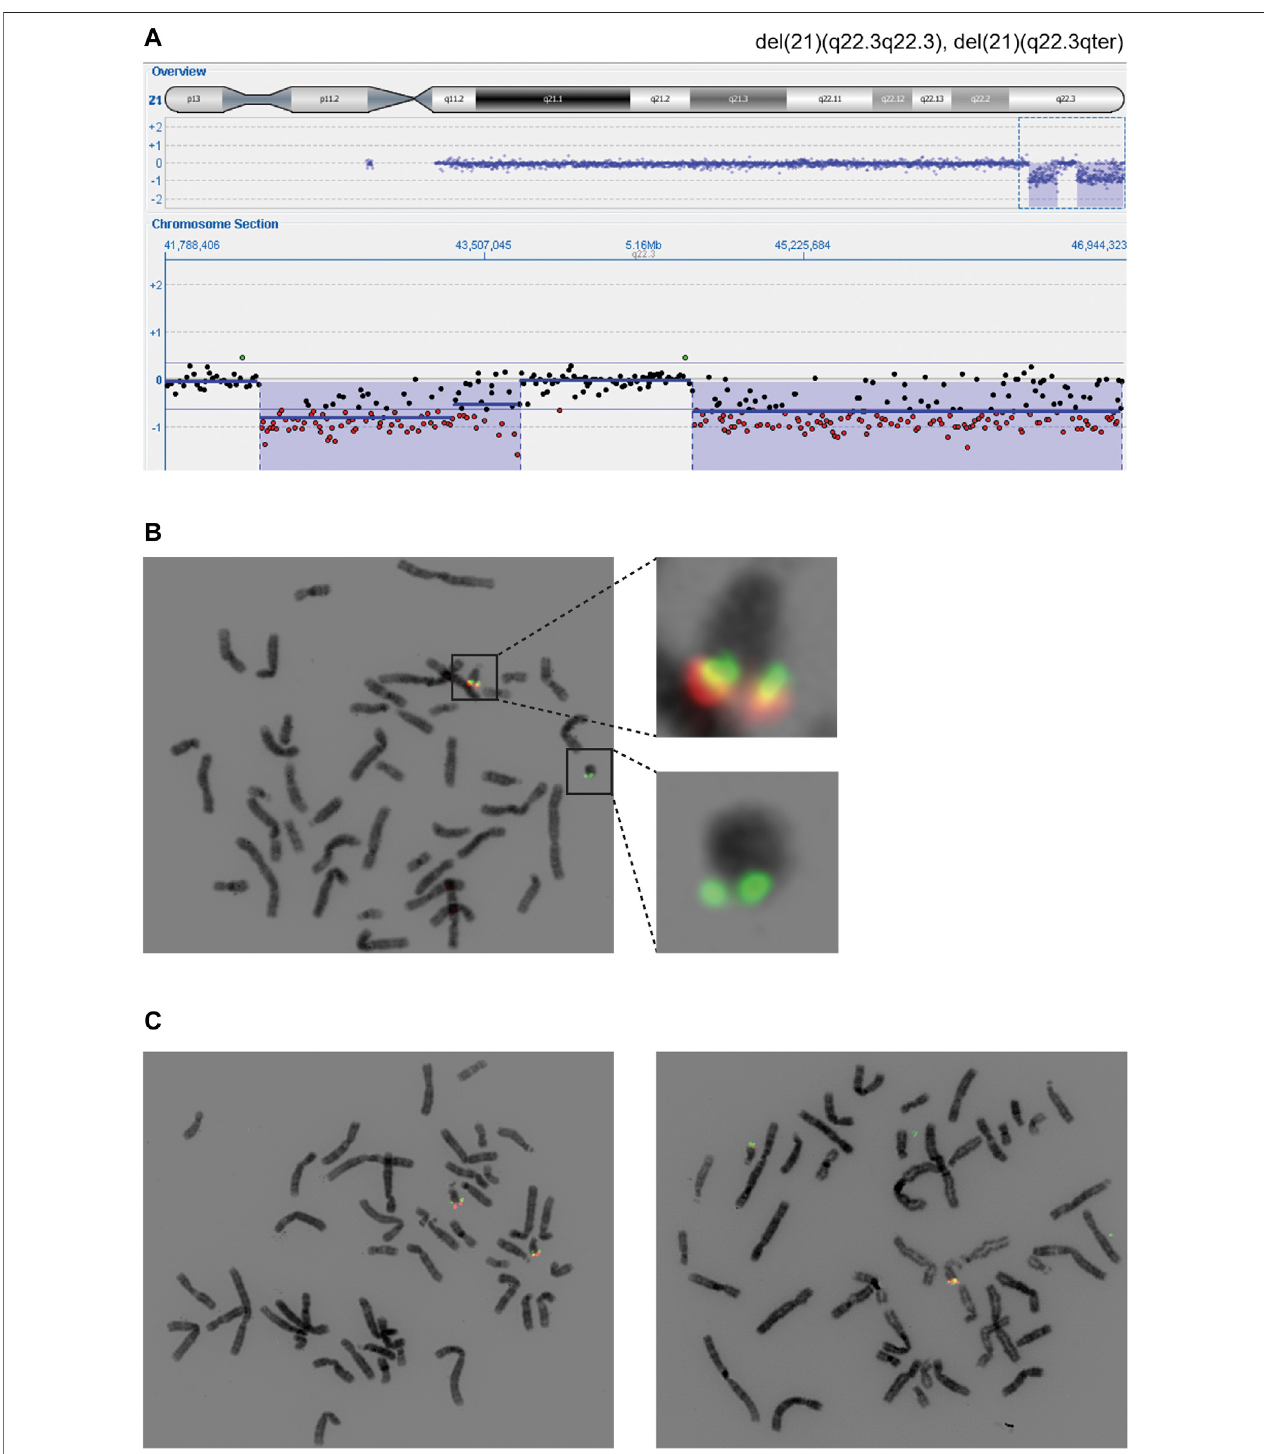
FIGURE 2 | Cytogenetic fi ndings revealing distal deletions on chromosome 21q (A) The 21qter deletions (blue) were found using array comparative genomic hybridization and visible due to the hemizygous detection level (red) (B) Fluorescent in-situ hybridization using probes within deletion one and 2 (red) and outside of deletedareas (green). Regionsofinterest areshown inhigher magni fi cation (C) Twoprobes (red, green) wereused to con fi rm the homozygousstate ofdistalregions on chromosome 21q in the maternal (left) and paternal (right) cell lines coming from peripheral blood. The probes used are identical with the ones in panel B and hybridize with a region in 21q22.3 (red) and 21q:22.2 (green).